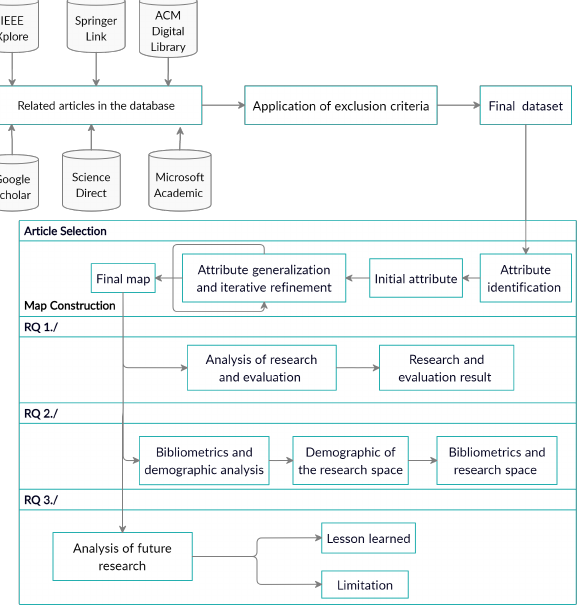
Figure 1. SM protocol. Article selection, Mapping, RQ 1, RQ 2, RQ